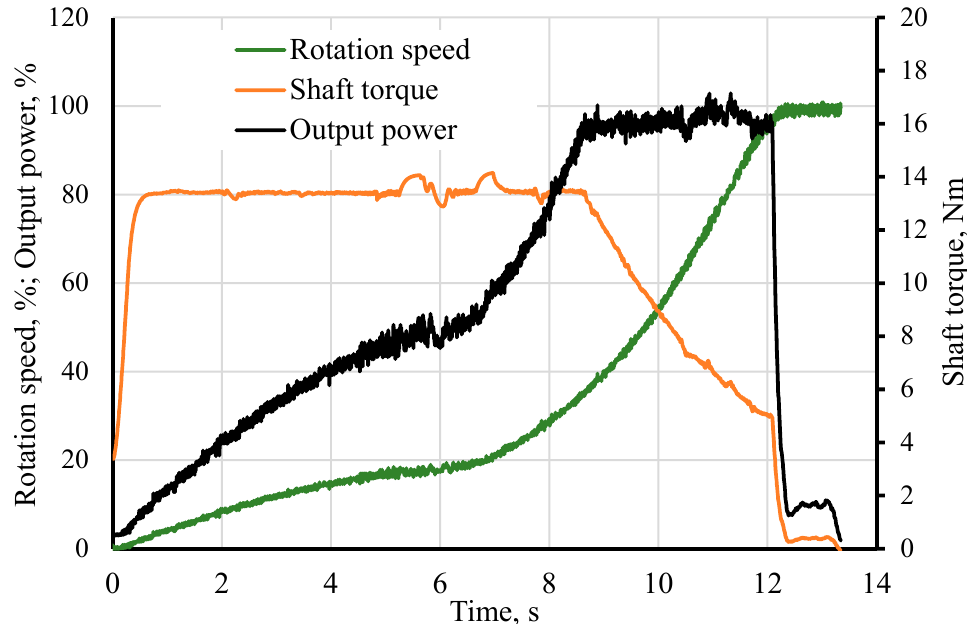
Figure 9. Dependence of the speed, power consumption and SG shaft torque on time during engine start.